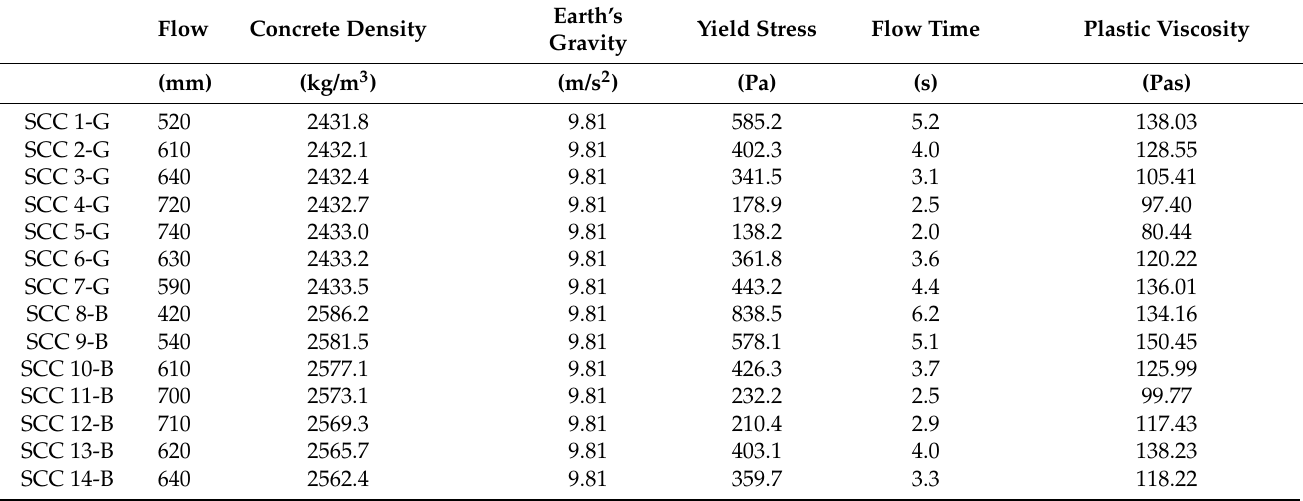
Table 17. Determining the yield stress and plastic viscosity on the basis of analyses performed using the Abrams inverted